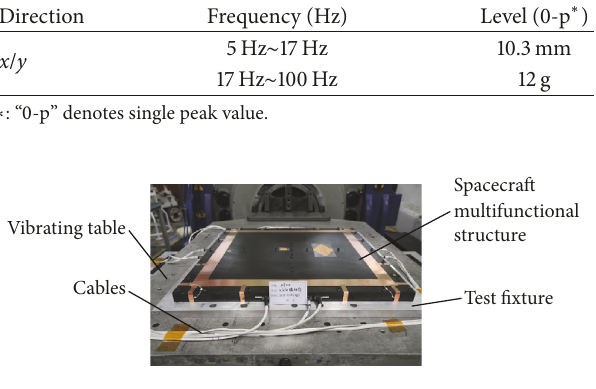
Figure 9: Live photo of the sinusoidal vibration experiment.